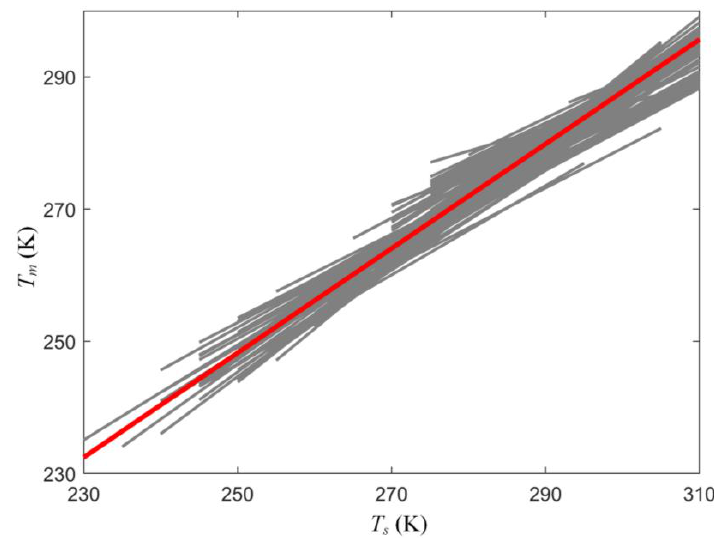
Figure 3. The unified T s ∼ T m linear model (red line) and site-specific models (gray lines). The range of T s for a site-specific model describes the surface temperatures that the station real observed.